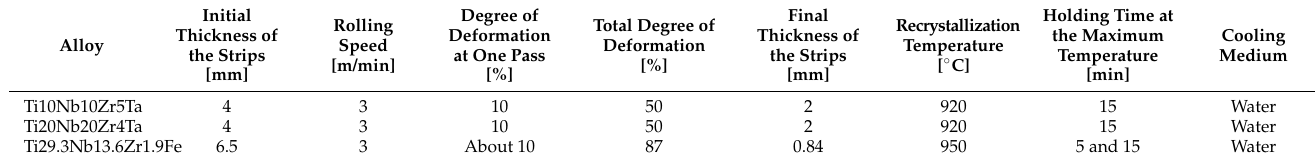
Figure 10. SEM fracture surface of the alloys processed: ( a ) Ti10Nb10Zr5Ta; ( b ) Ti20Nb20Zr4Ta; ( c ) Ti29.3Nb13.6Zr1.9Fe; ( d ) Ti29,3Nb13,6Zr1,9Fe laminated; ( e )Ti29.3Nb13.6Zr1.9Fe recrystallized for 5 min; and ( f ) Ti29.3Nb13.6Zr1.9Fe recrystallized for 15 min. Table 4. Process parameters for the thermo-mechanical treatment of the